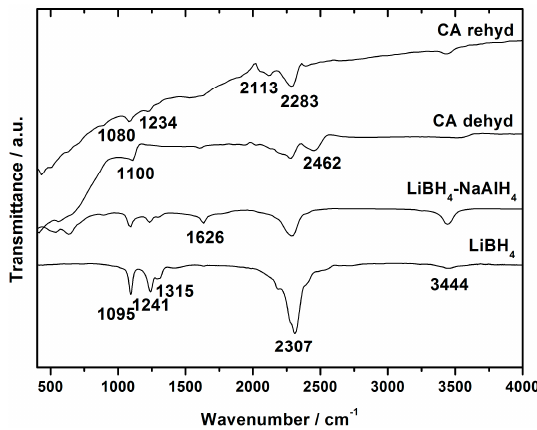
Figure 5. FTIR spectra of bulk LiBH 4 , 2LiBH 4 -NaAlH 4 (LiNa), and nanoconfined 2LiBH 4 -NaAlH 4 CA-LiNa after dehydrogenation at 500 °C for the third time and finally CA-LiNa rehydrogenated at p (H 2 ) = 140 bar, T = 400 °C for 10 h after three desorption cycles. The intensity of the spectra with the carbon containing samples was scaled corresponding to their quantity of LiNa to allow for better comparison.